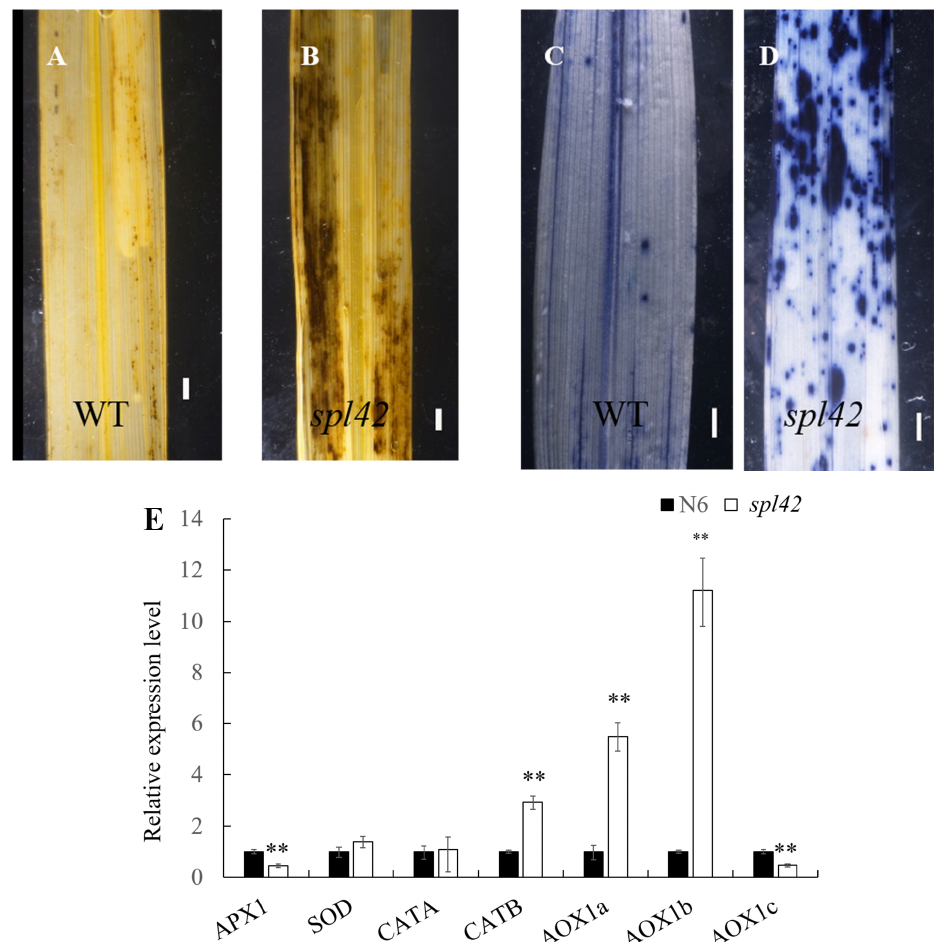
Figure 3. Comparison of reactive oxygen species (ROS) activity between wild-type and spl42 mutants and expression analysis of genes related to ROS scavenging. ( A , B ) Hydrogen peroxide (H 2 O 2 ) was visualized by diaminobenzidine (DAB) staining. Scale Bar = 0.1 cm. ( C , D ) Superoxide anion (O 2 − ) was visualized by nitro-blue tetrazolium (NBT) staining. Scale Bar = 0.1 cm. ( E ) qRT-PCR analysis of the genes related to ROS scavenging systems. Error bars represent ± SD ( n = 3). Asterisks indicate a significant difference between NingJing6 (N6) and the spl42 plants by Student’s t -test, ** p < 0.01.